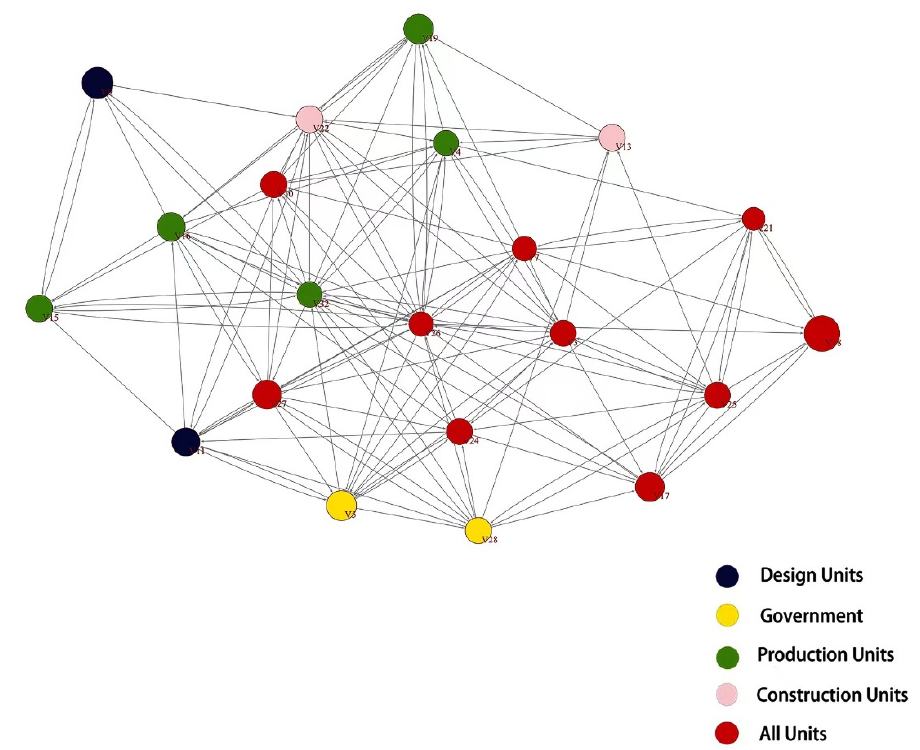
Figure 6. Visualization of clustering coefficients.